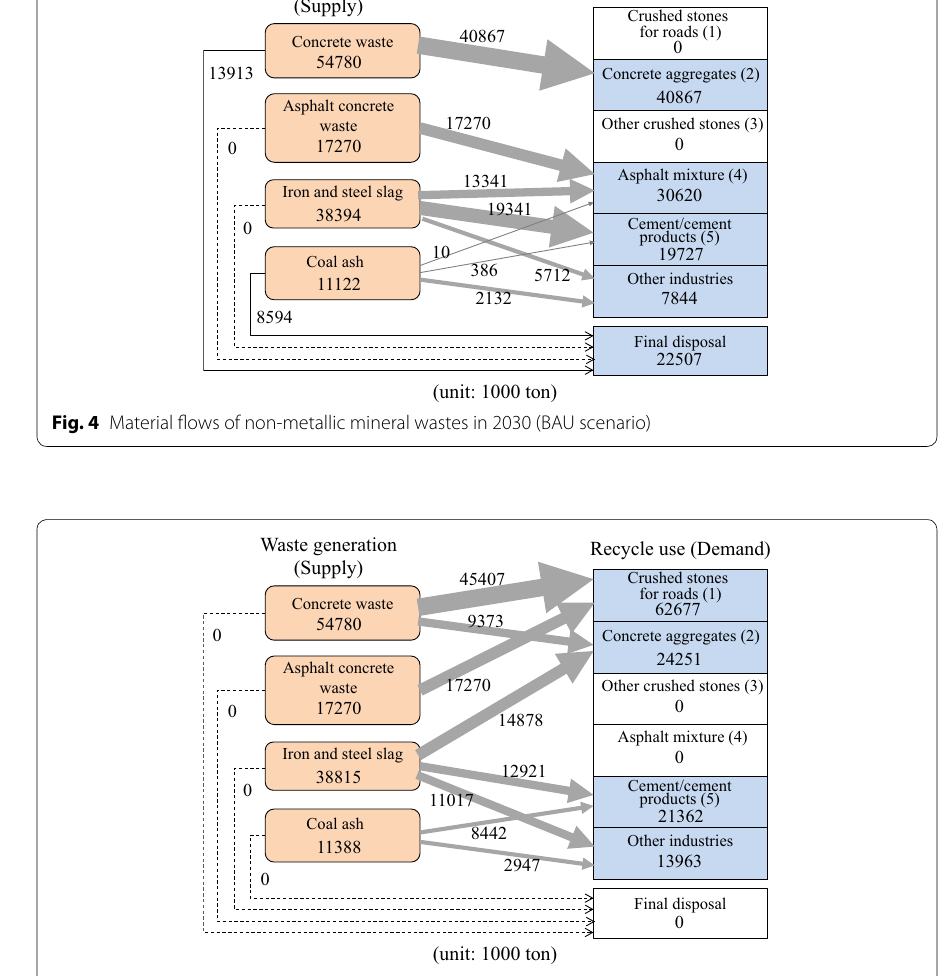
Fig. 5 Material flows of non-metallic mineral wastes in 2030 (zero emission